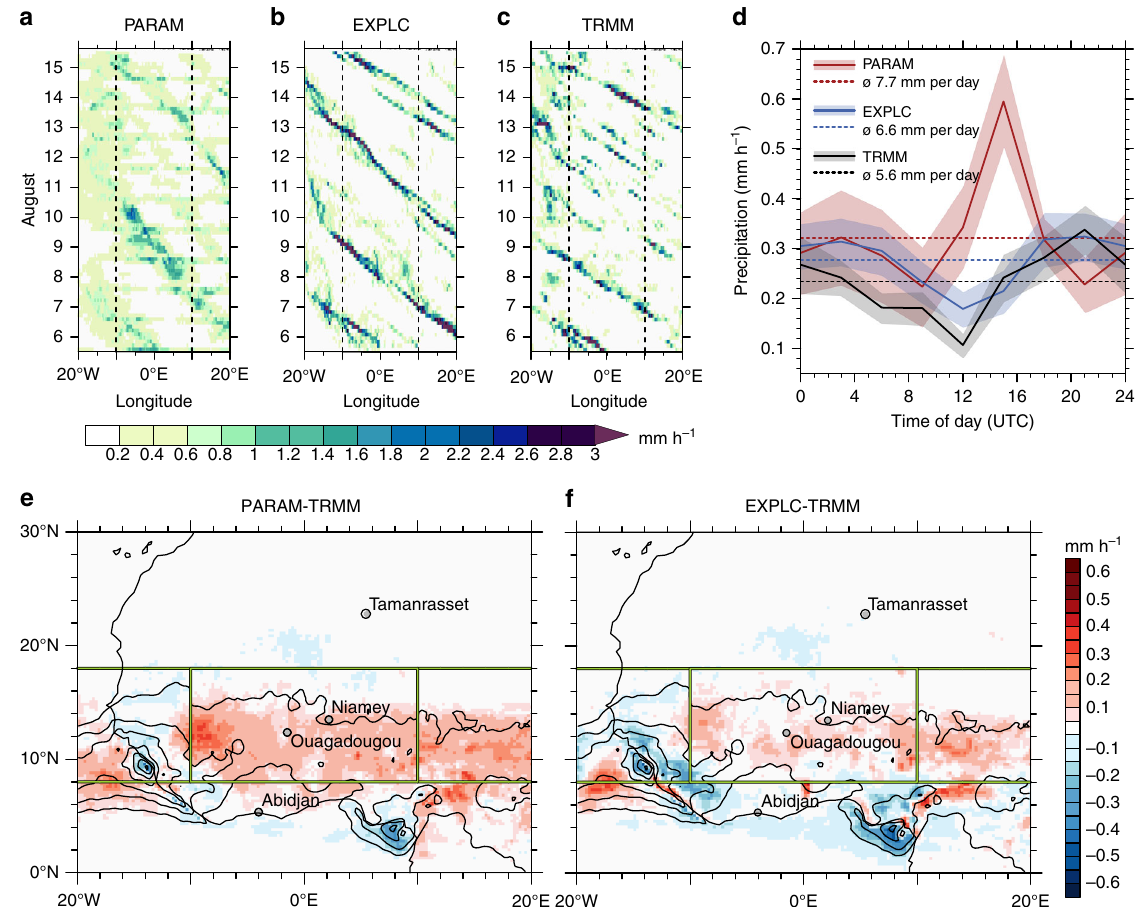
Fig. 1 Model performance in simulating precipitation in West Africa. a – c Hovmoeller diagrams of 3-hourly precipitation averaged from 8°N to 18°N for the time period from 12 UTC (Coordinated Universal Time) 5 August 2017 (initialisation of ICOsahedral Nonhydrostatic (ICON simulations) to 12 UTC 15 August 2017 for model simulations employing the convection parameterisation (PARAM, a ) and explicitly resolving convection (EXPLC, b ), as well as Tropical Rainfall Measuring Mission (TRMM) observations ( c ). d Diurnal cycle of precipitation averaged from 8°N to 18°N and from 10°W to 10°E (dashed vertical lines in a – c and boxes in e , f ). Shown are averages (bold lines)± standard deviation (shading) over all 124 simulations of the 10-day forecast ’ s mean diurnal cycle and the respective average for TRMM observations. e Precipitation bias for PARAM over all 124 simulations with averaging box from d and latitude band from a to c as well as radiosonde station locations used in this study indicated. Solid black lines show the corresponding TRMM climatology in steps of 0.2 mm h − 1 . f As e but for